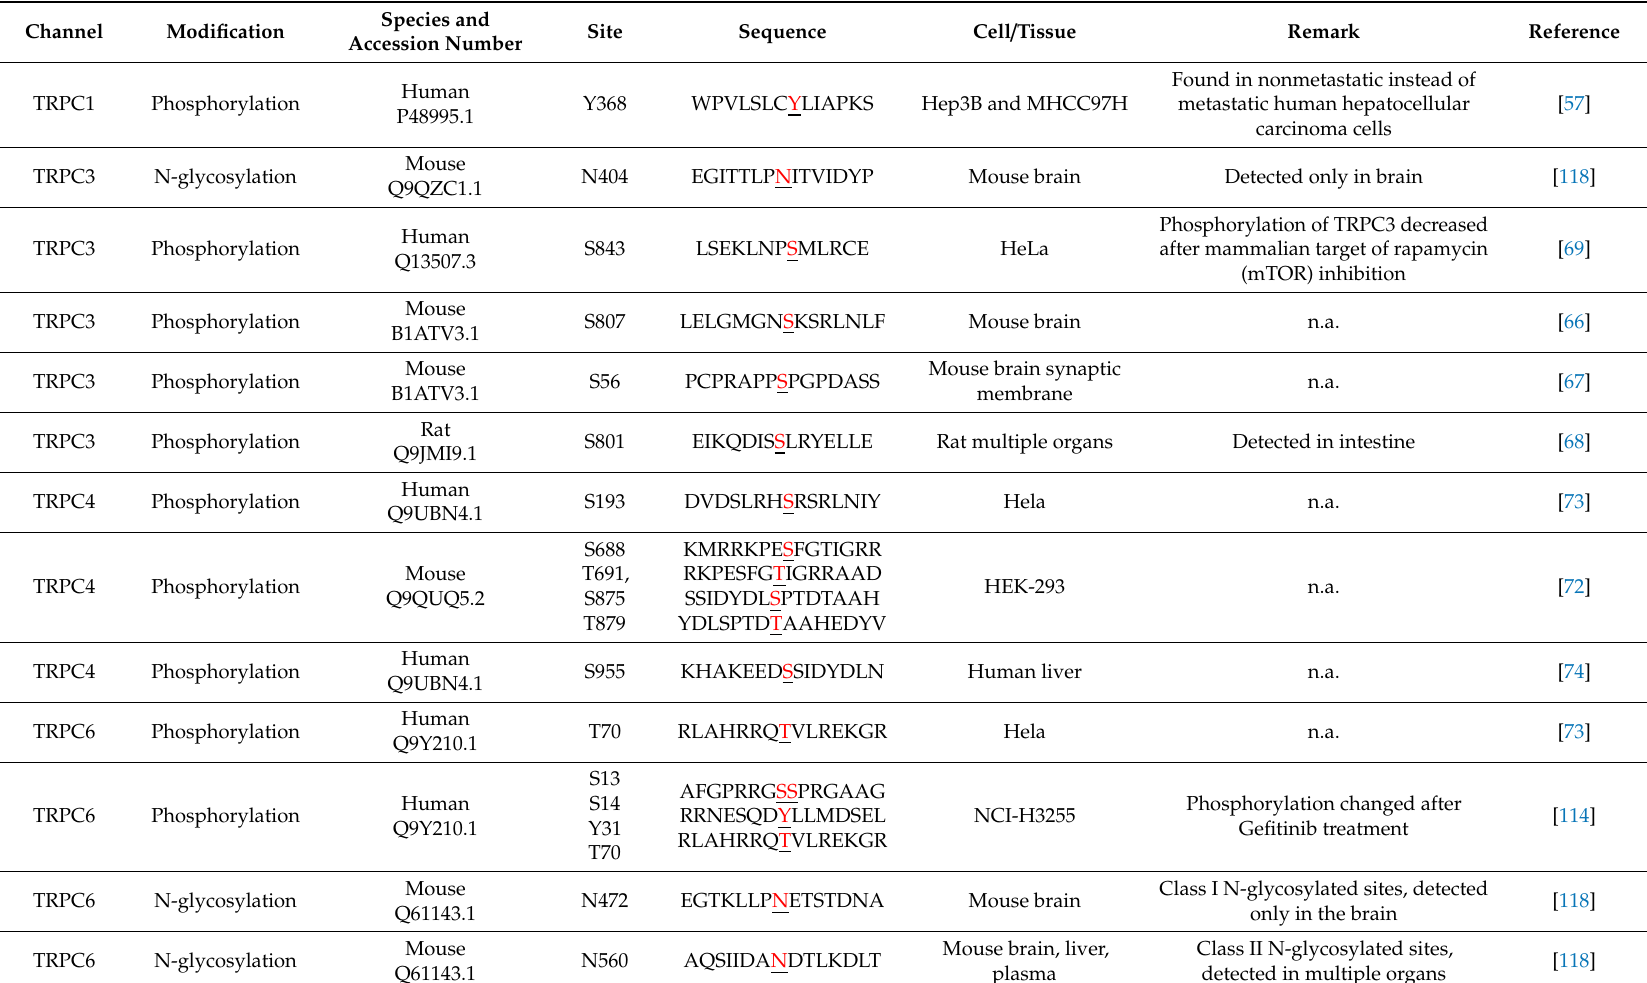
Table 2. PTMs of di ff erent members of TRPC as reported by high throughput